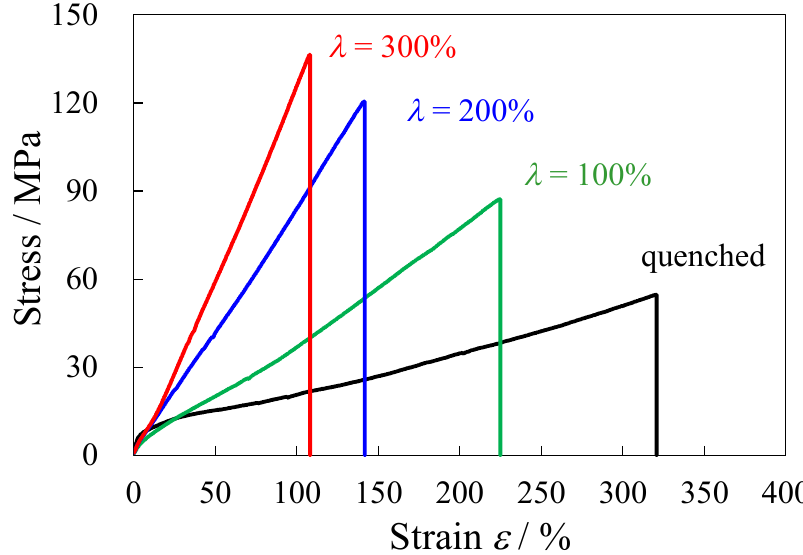
Figure 1. Stress–strain curves of the heat-elongated TPU films obtained at various elongation ratios λ .